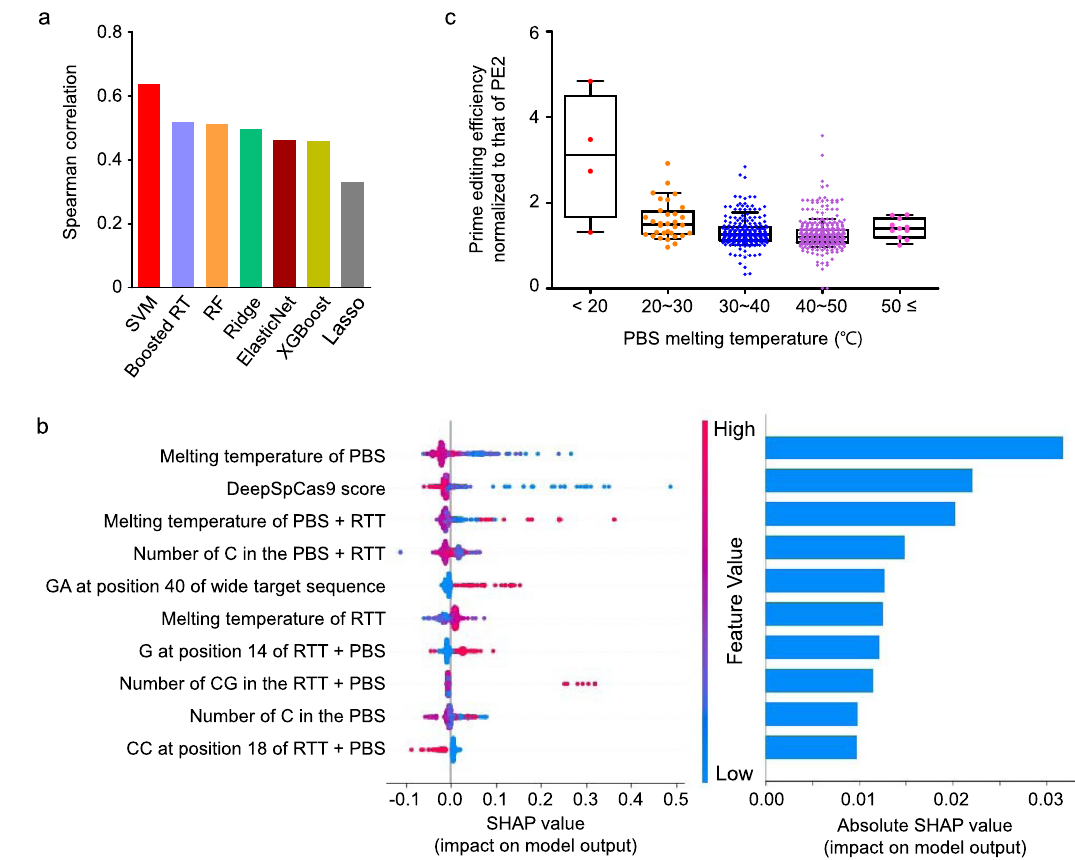
Fig. 4 Development and evaluation of PEselector, a computational model that predicts the fold increase of hyPE2-induced prime-editing ef fi ciencies as compared to those of PE2. a Comparison of Spearman correlation coef fi cients between prediction models. SVM, support-vector machine; Boosted RT, gradient-boosted regression tree; RF, random forest; Ridge, L2-regularized linear regression; ElasticNet, L1L2-regularized linear regression; XGBoost, extreme-gradient boosting; Lasso, L1-regularized linear regression. b The top ten features associated with hyPE2 activity as compared with PE2 activity determined by Tree SHAP (XGBoost classi fi er). The dot colors indicate the high (red) or low (blue) values of the relevant feature for each pegRNA. Overlapping points are slightly separated in the y-axis direction, so that density is apparent. c Dependence of the fold increase in hyPE2 prime-editing ef fi ciency relative to that of PE2 on the primer-binding site (PBS) melting temperature. Editing ef fi ciencies for hyPE2 and PE2 were determined at the same target sequences, which had been lentivirally integrated in HEK293T cells (library B). Data points are overlaid. The number of pegRNAs n = 4 (<20 °C), 32 (20 – 30 °C), 236 (30 – 40 °C), 348 (40 – 50 °C), and 11 ( ≥ 50 °C). Data of minimum-to-maximum values are presented. For the boxes, the top, middle, and bottom lines represent the 25th, 50th, and 75th percentiles, respectively. The whiskers indicate the 10th- and 90th-percentile values. Source data are provided as a Source Data fi